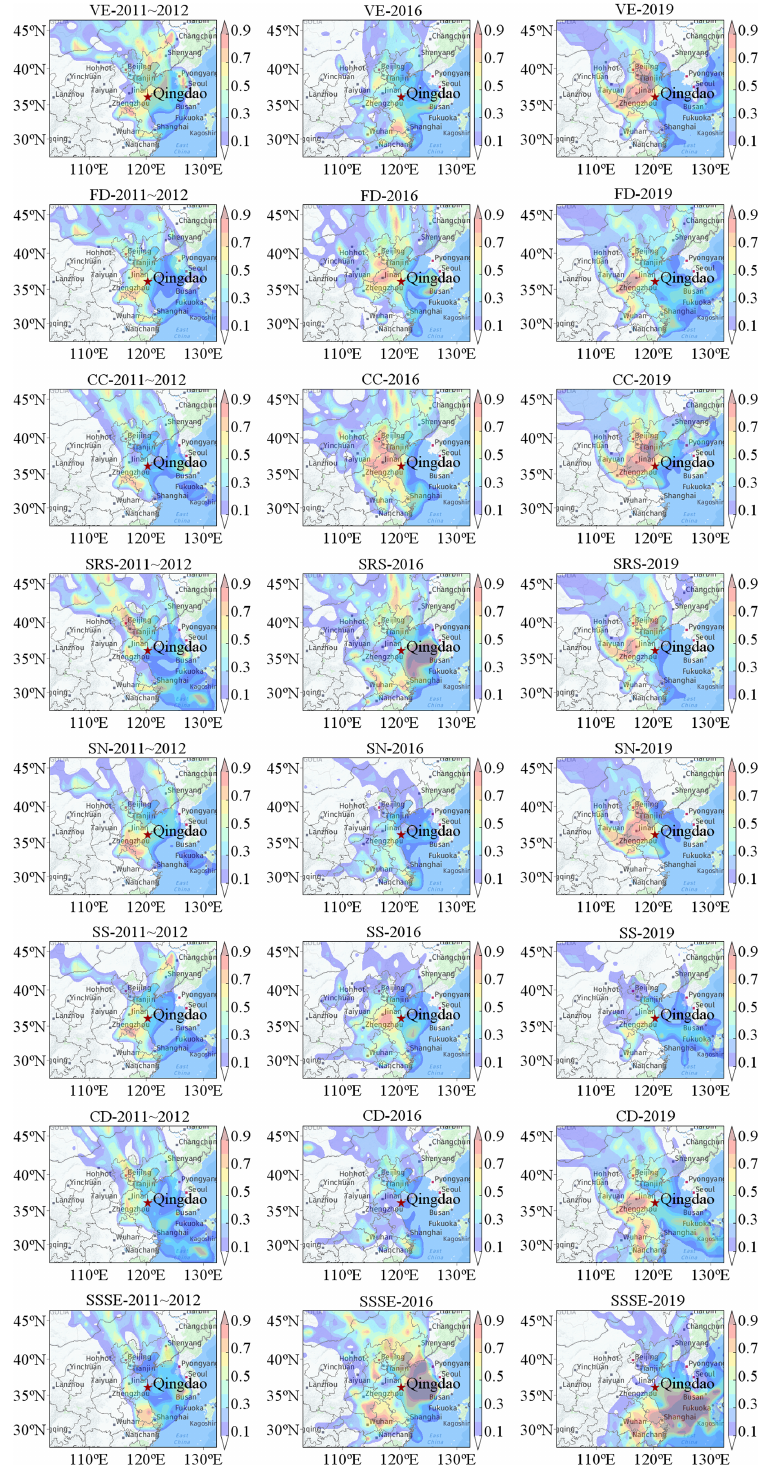
Figure 6. Weighted PSCF plots for various emission sources during different periods (base map from Yahoo! Maps). VE represents vehicle emissions, FD represents fugitive dust, CC represents coal combustion, SRS represents steel-related smelting, SN represents secondary nitrate, SS represents secondary sulfate, CD represents construction dust, and SSSE represents sea salt and ship